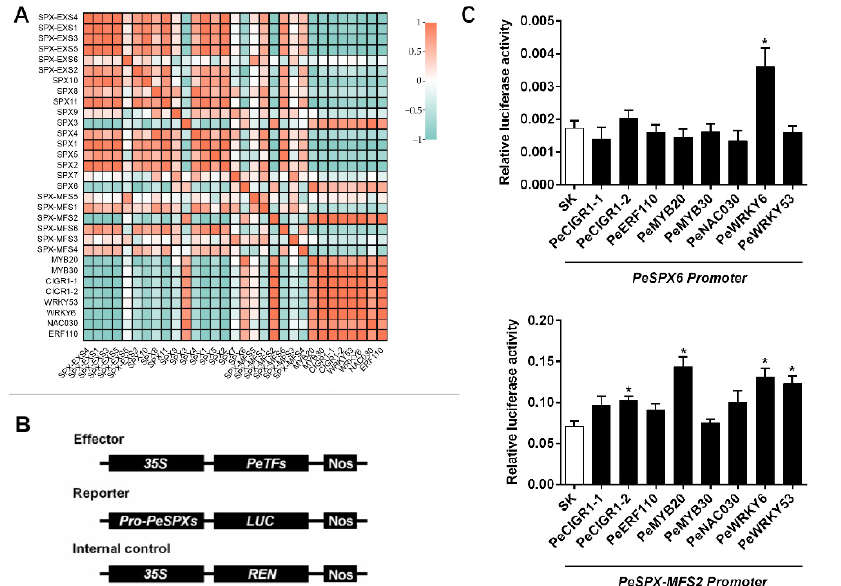
Figure 6. Validation of the regulatory networks of PeSPX6 and PeSPX-MFS2 . ( A ) Pearson’s correla- analysis between the expression levels of PeSPX6 and PeSPX-MFS2 and transcription factors induced by low phosphorus. ( B ) Schematic diagrams of the effector and reporter plasmids used for transient expression analysis. ( C ) Dual-luciferase analysis of the effects of potential transcription factors on LUC activity driven by the PeSPX6 and PeSPX-MFS2 promoter. The asterisk shows a significant difference compared to the control using the unpaired Student’s t test (* p <